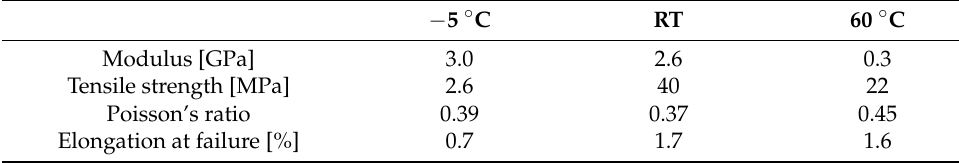
Table 1. Tensile properties of EPON 815C epoxy cured with Epikure TM 3140.